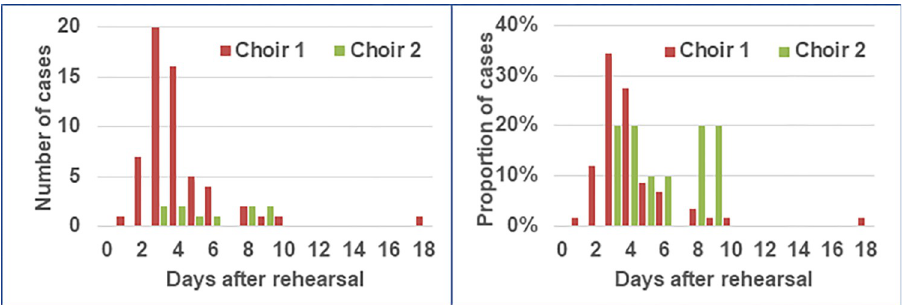
Fig 2. Frequency distribution of cases of choir 1 and 2 by day of symptom onset after the respective rehearsals, Berlin, March 2020. Left: frequency of number of cases, right: proportion of cases.